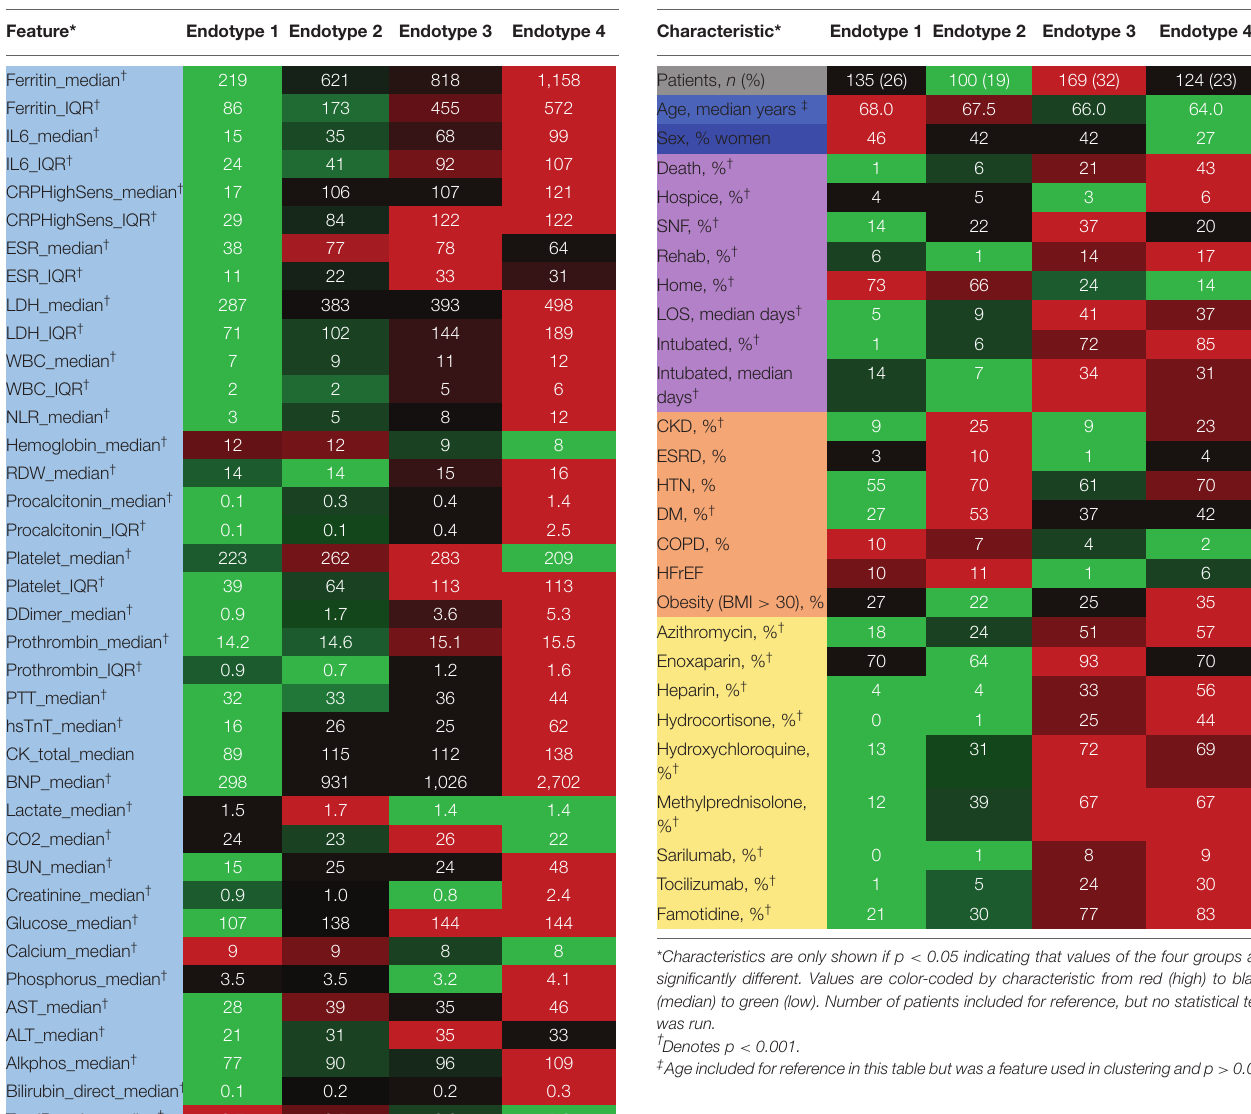
TABLE 3 | Endotype characteristics. Characteristic*